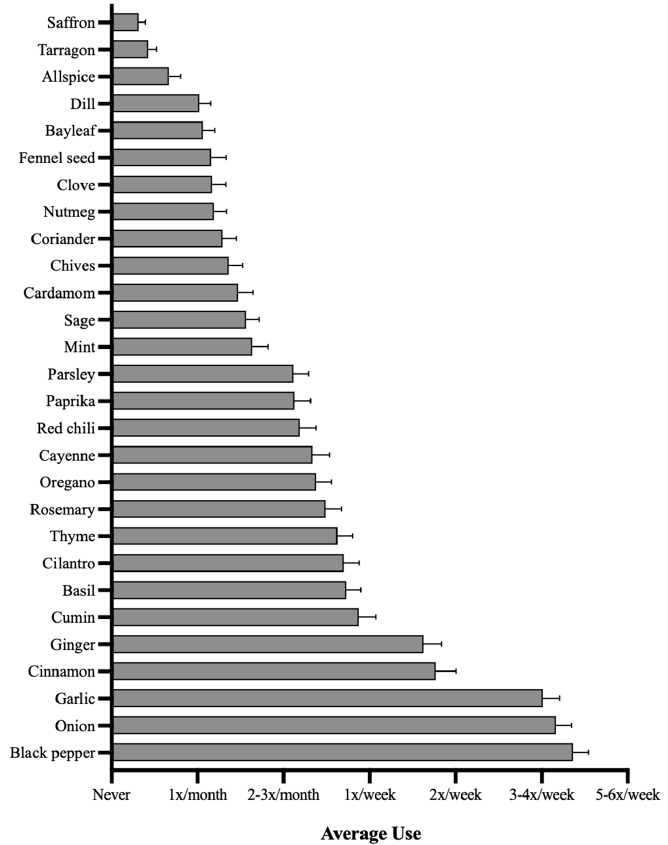
Figure 1. Average frequencies of culinary herb and spice use. Shown are the average frequencies of culinary herb and spice use with standard error bars, ranging from: Never, once per month, 2 to 3 times per month, once per week, twice per week, 3 to 4 times per week, and 5 to 6 times per week. No herbs averaged daily use. Herbs are displayed from least frequently used (top) to most frequently used (bottom).